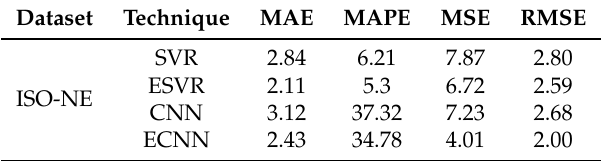
Table 5. Performance Evaluation Metrics for Load Prediction